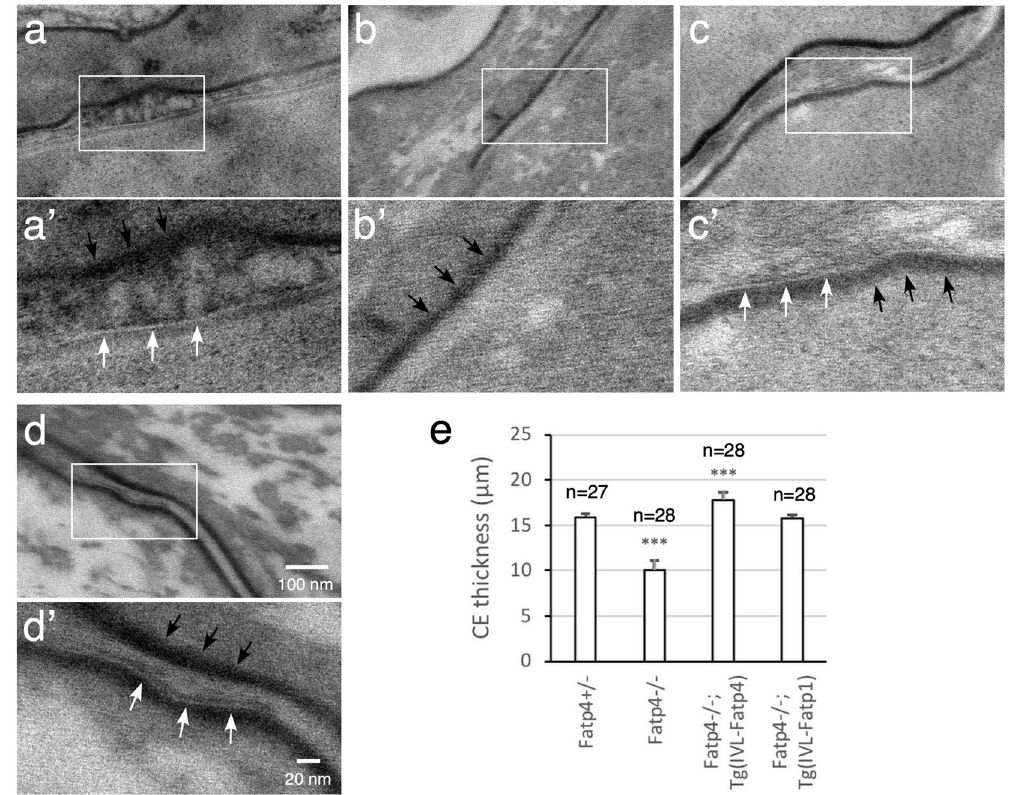
Figure 2. Defects in ultrastructure of Fatp4 − / − corneocyte lipid envelope (CLE) and cornified envelope (CE). The CLE and CE were examined by transmission electron microscopy as described in Materials and Methods. The boxed regions in a to d are magnified in a’ to d’ , respectively. White arrows indicate typical CLE morphology: a regular, 4 nm thick lucent band on the external face of the CE (black arrows). Fatp4 − / − stratum corneum ( b’ ) was characterized by no visible CLE and a thin CE compared to control ( a’ ), FATP4- ( c’ ), and FATP1- ( d’ ) rescued mice. Representative images are shown from two mice of each genotype. CE thickness was quantified ( e ) as described in Materials and Methods with the n numbers, standard deviation, and statistical significance indicated ( *** P < 0.001). IVL, involucrin